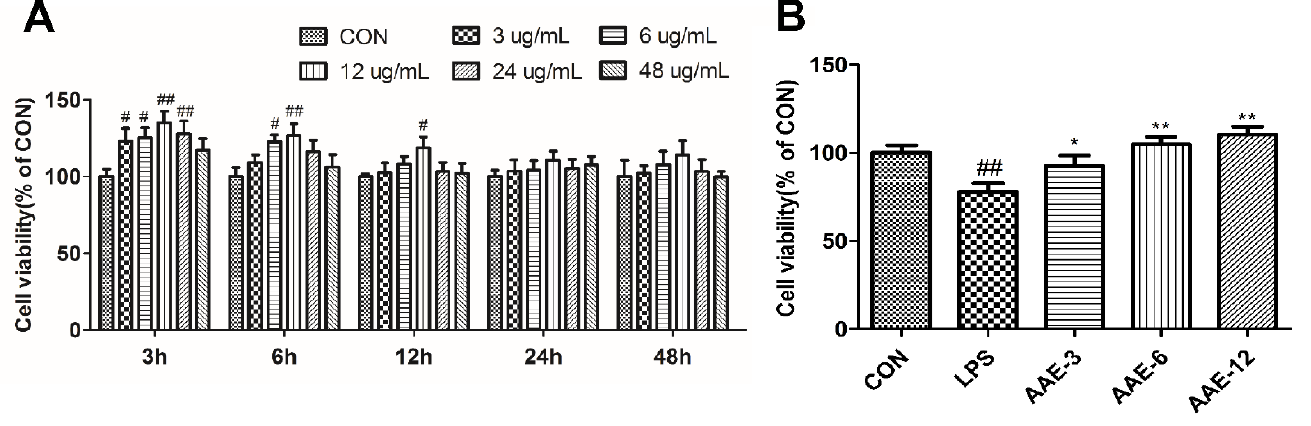
Figure 2. Ethanol extract of Artemisia annua (AAE) increased cell viability of bMECs. ( A ) The bMECs were treated with different concentrations of AAE (3, 6, 12, 24 and 48 μ g/mL) for 3, 6, 12, 24 and 48 h. ( B ) The bMECs were treated with different concentrations (3, 6 and 12 μ g/mL) of AAE for 3 h, and then incubated with 10 μ g/mL LPS for 12 h. Cell viability was determined by MTT method. CON: cells were cultured in medium (serum-free) for 15 h; LPS: cells were cultured in medium (serum-free) for 3 h and then incubated with 10 μ g/mL LPS for 12 h; AAE-3, AAE-6 and AAE-12: cells were treated with 3, 6 and 12 μ g/mL AAE for 3 h before 10 μ g/mL LPS incubation for 12 h. Comparisons among groups were made with ANOVA followed by Duncan’s test. The data are ex- pressed as mean ± SEM ( n = 6). # p < 0.05 and ## p < 0.01 vs. CON. * p < 0.05 and ** p < 0.01 vs. LPS.